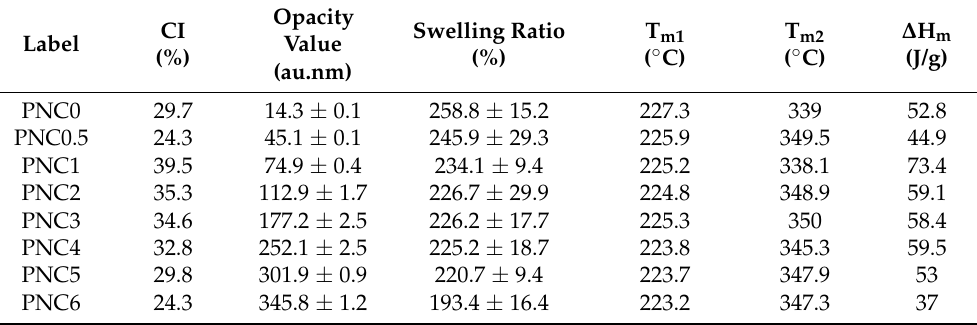
Table 3. The physicochemical properties of PVA–NCC nanocomposite films.